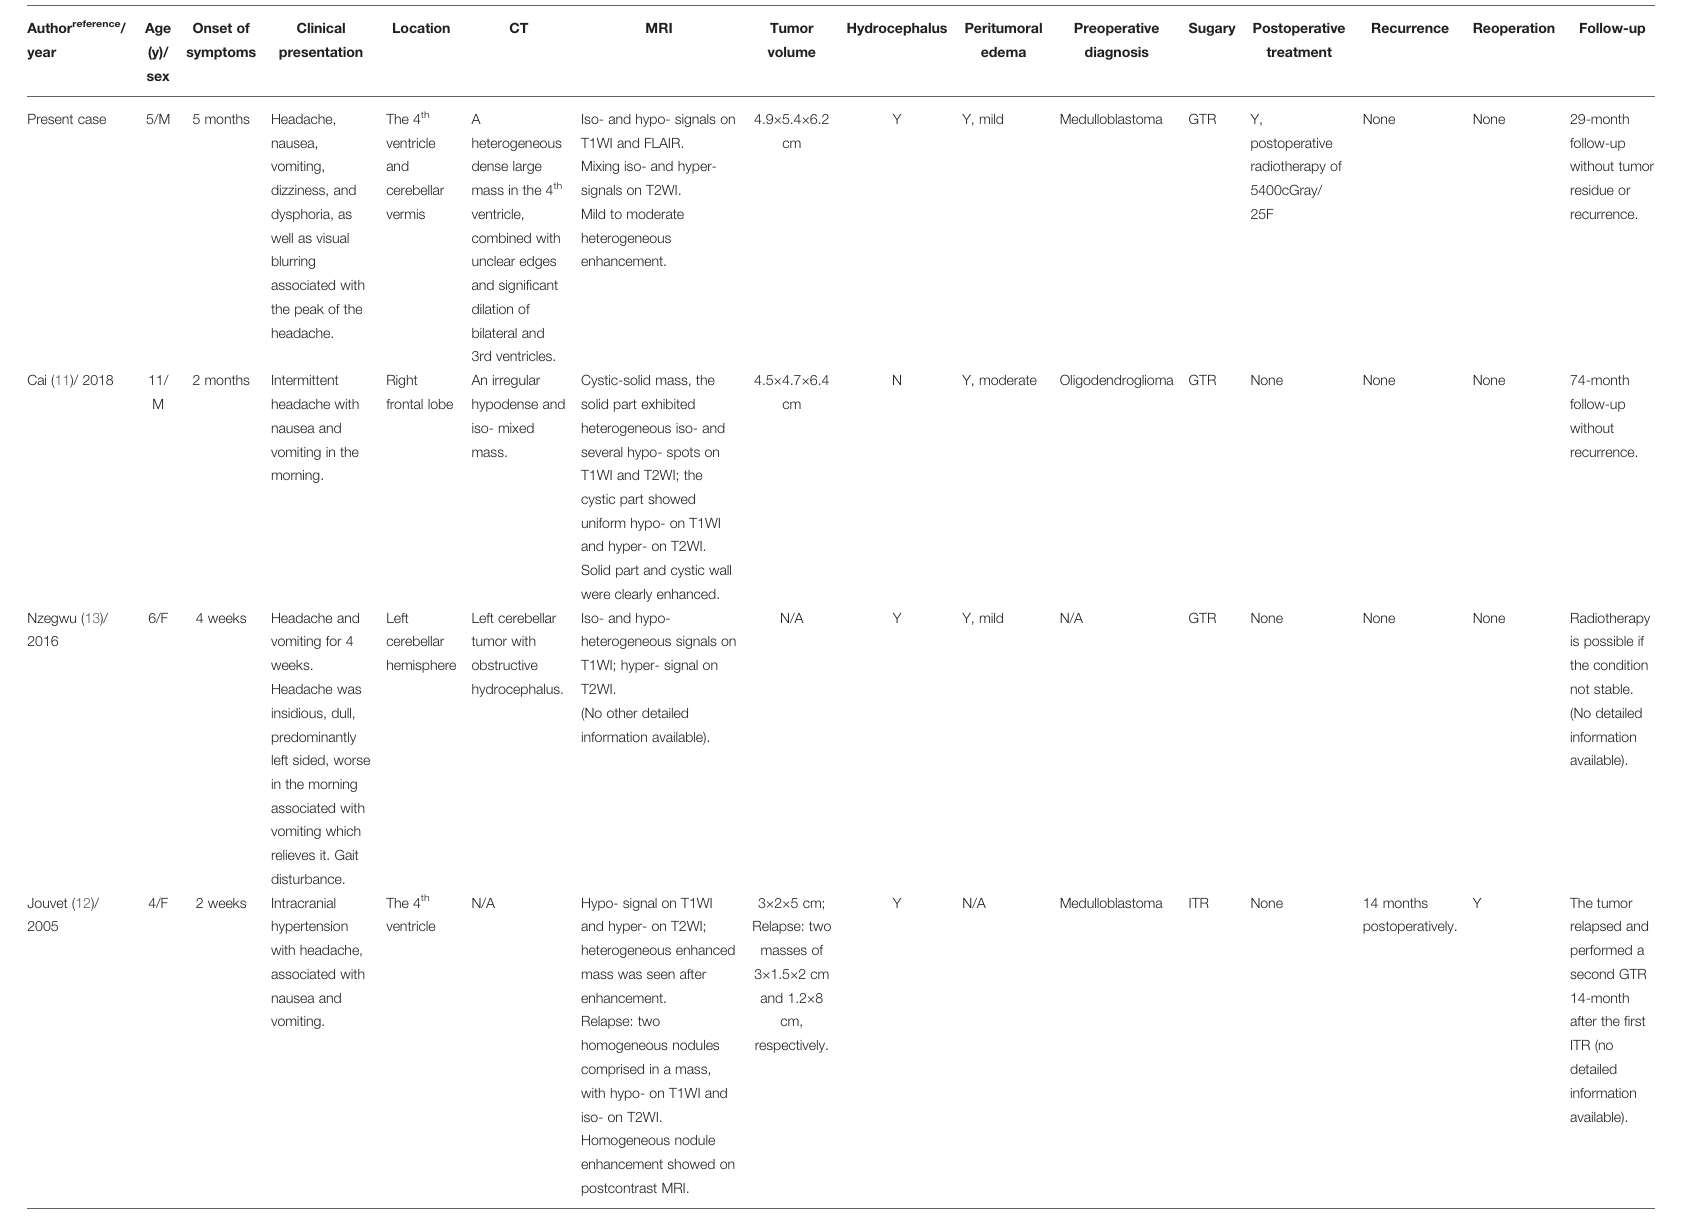
TABLE 1 | The clinical characteristics of four pediatric patients with